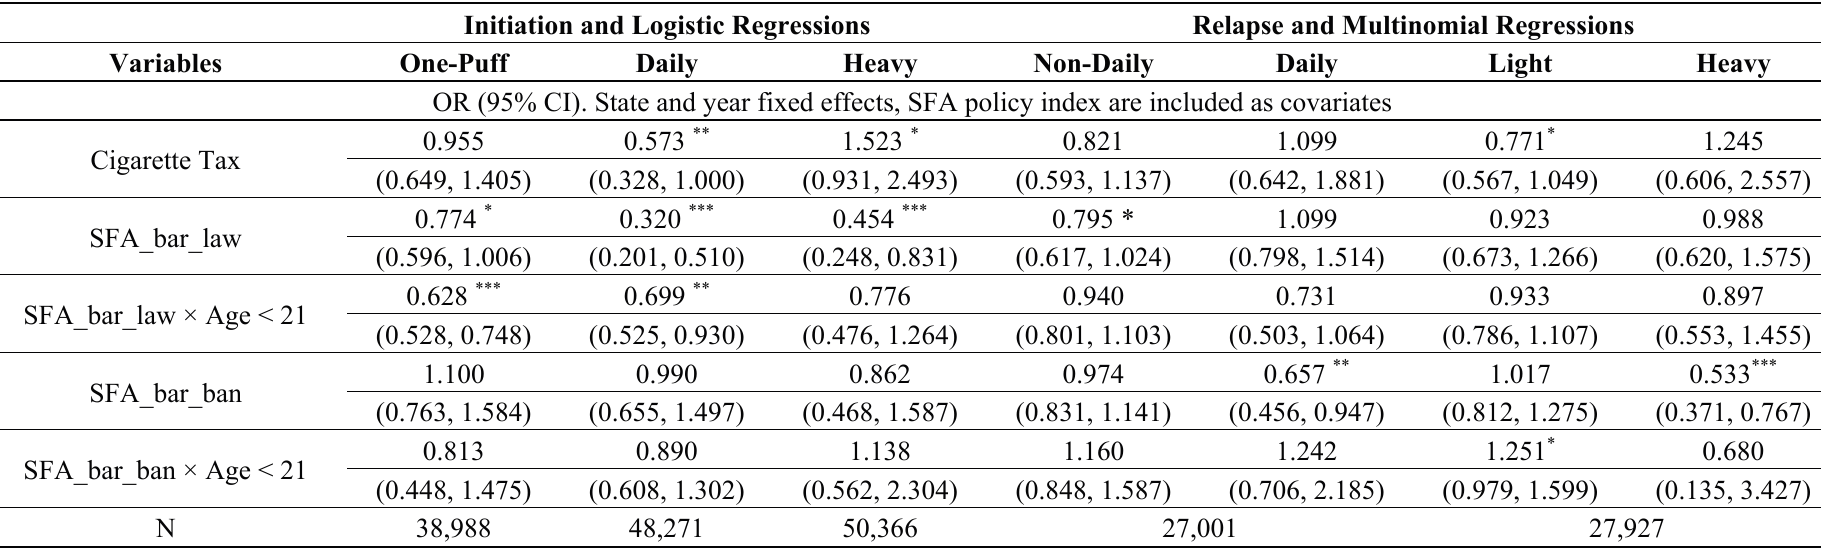
Table 3. The effects of SFA in bars on smoking initiation_NLSY97, 1997–2009. Initiation and Logistic Regressions Relapse and Multinomial